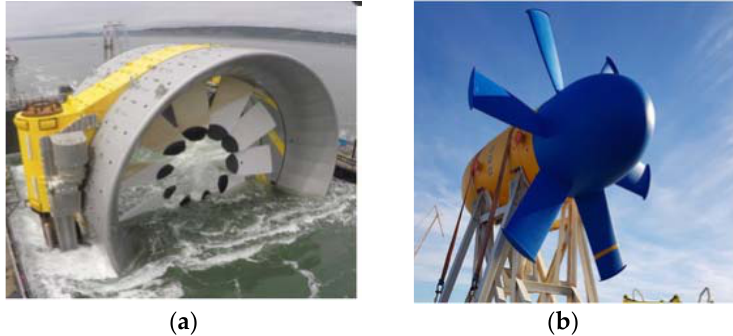
Figure 2. ( a ) Water turbine with high solidity [3]. ( b ) Water turbine with low solidity [3].